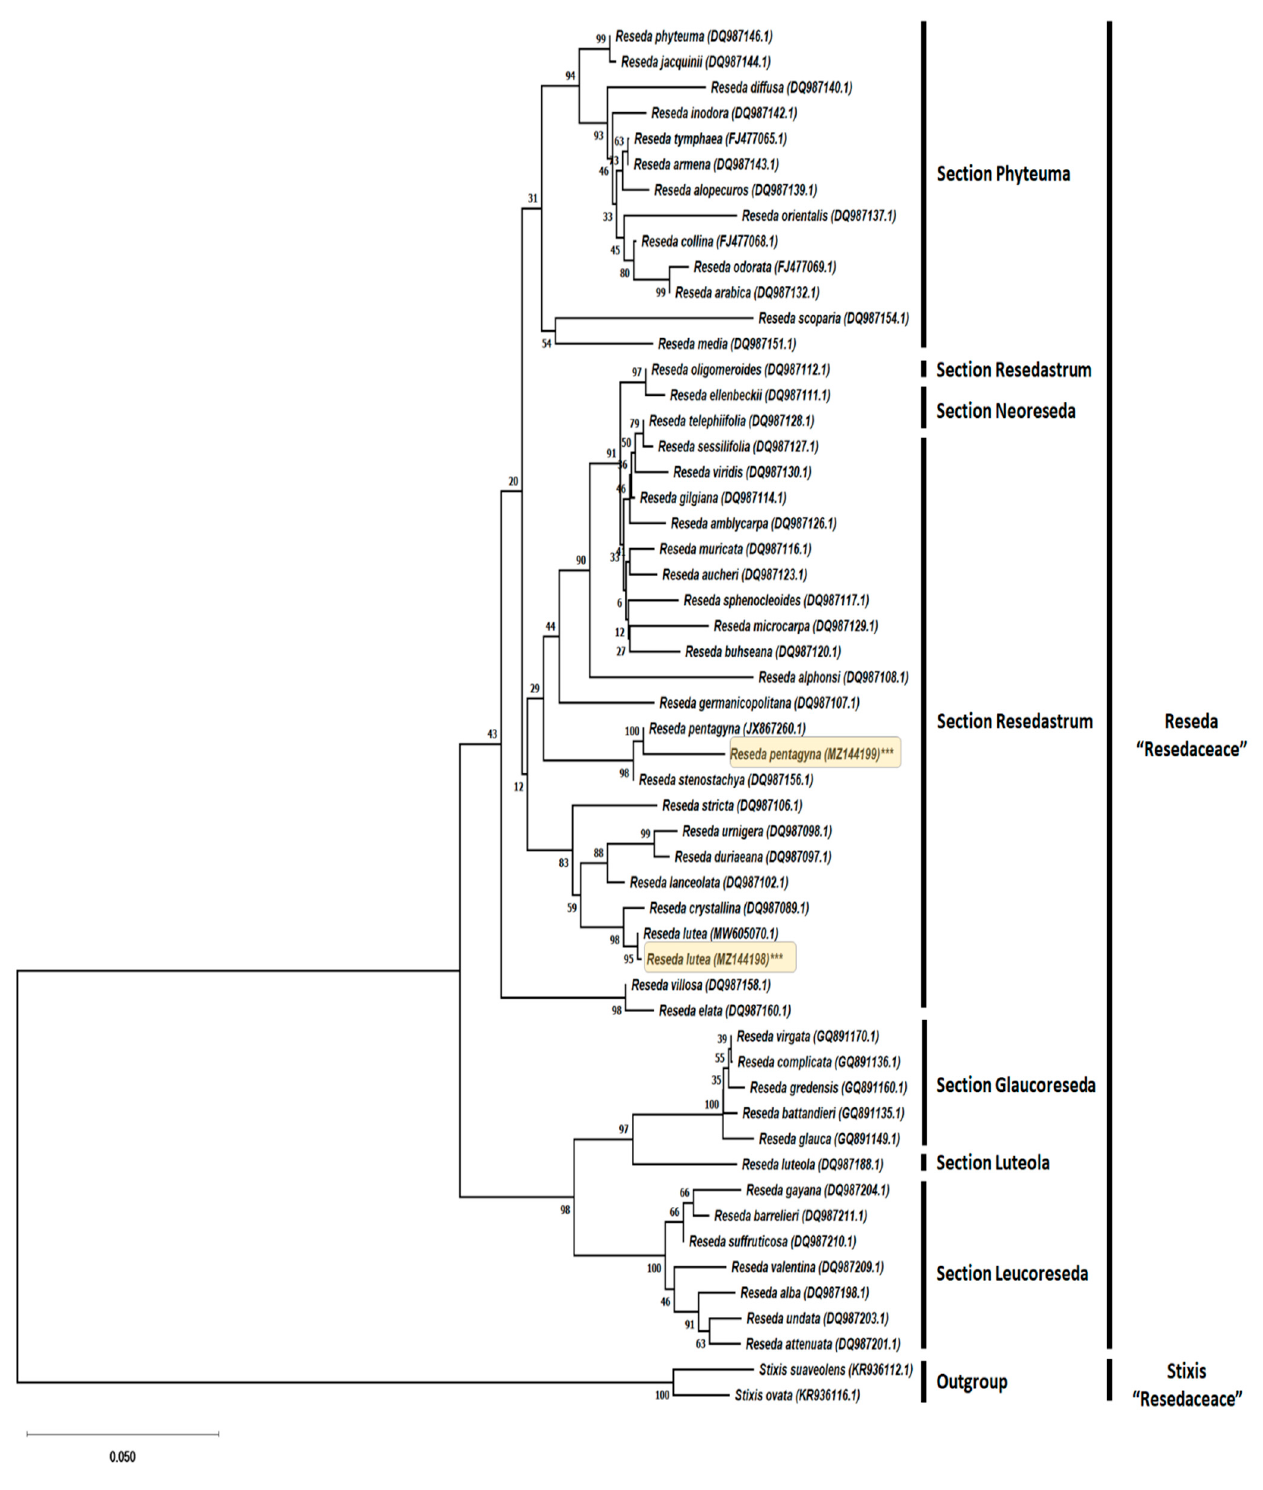
Figure 2. Molecular identification of Reseda lutea and Reseda pentagyna (highlighted) was conducted via evolutionary analyses in MEGA X and inferred from the analysis of internal transcribed spacer (ITS) sequence using the Neighbor-Joining algorithm. Next to the branches is the percentage of replicate trees around which the linked taxa grouped with each other in the bootstrap test (2000 replicates). The Kimura 2-parameter model was used to calculate the evolutionary distances (NCBI accession numbers between brackets).